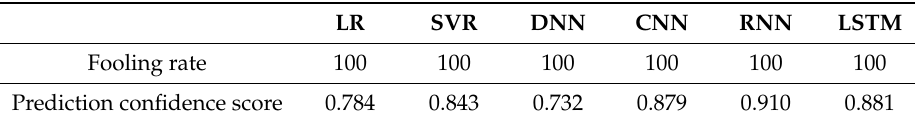
Table 2. Fooling rate and prediction confidence of the